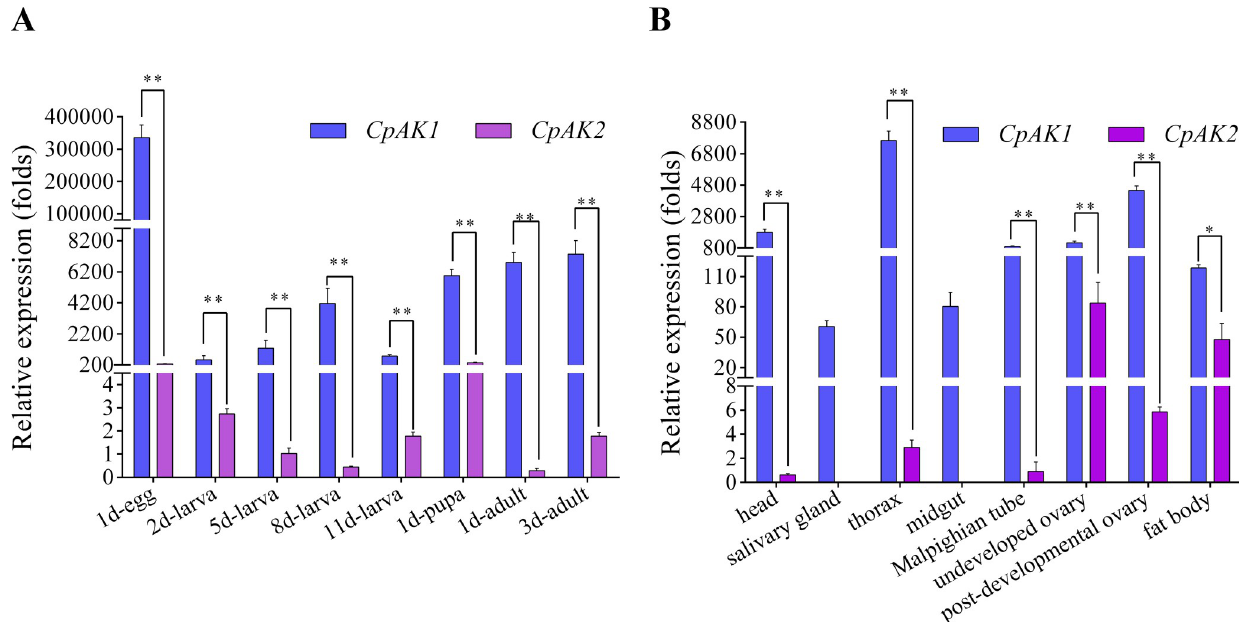
Fig 3. The relative mRNA expression levels of CpAK1 and CpAK2 in different developmental stages (A) and various tissues (B) of Cx . pipiens pallen s. The mRNA levels of target gene were normalized to the reference gene ( β -actin ) in the same sample and calculated using the 2 - ΔΔ CT method. 1d-egg: 1-day-old egg; 2d-larva: 2-day-old larva; 5d-larva: 5-day-old larva; 8d-larva: 8-day-old larva; 11d-larva: 11-day-old larva; 1d-pupa: 1-day-old pupa; 1d-adult: 1-day-old female adult; 3d-adult: 3-day-old female adult. All data were expressed as the mean ± Standard Error (SE). Significant difference was analyzed by one-way ANOVA test ( � P < 0.05, �� P < 0.01).